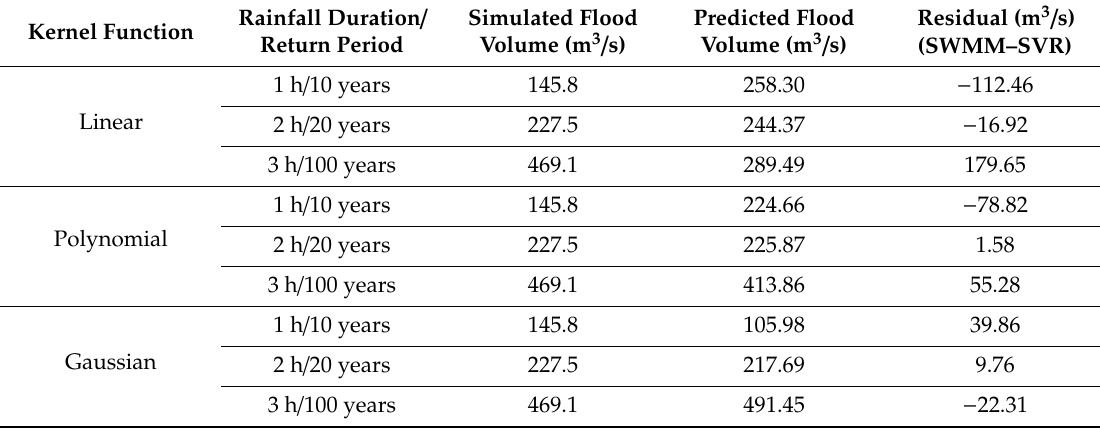
Figure 10. Results of support vector regression (Gaussian kernel function). ( a ) Rainfall duration 1 hour; ( b ) Rainfall duration 2 hours; ( c ) Rainfall duration 3 hours. Table 5. Flood volumes predicted using support vector regression (SVR).